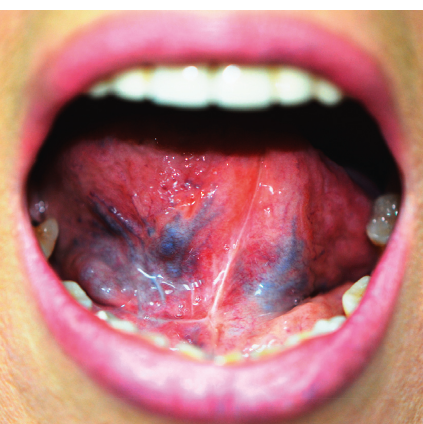
Figure 4: Postoperative image of the mouth reveals a normal appearance of the tongue and floor of the